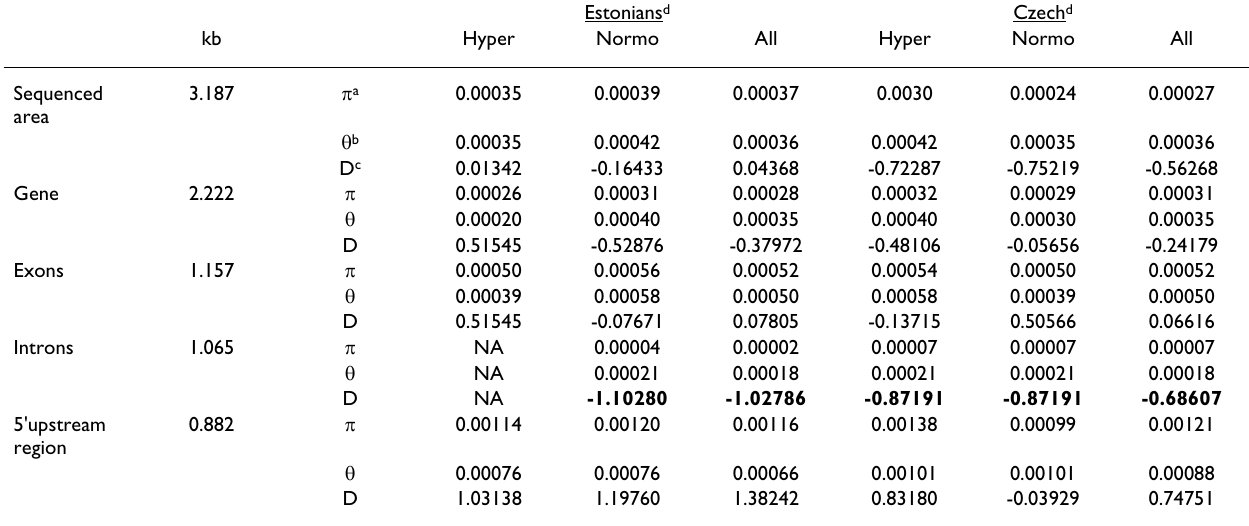
Table 3: Sequence diversity parameters of human PNMT gene